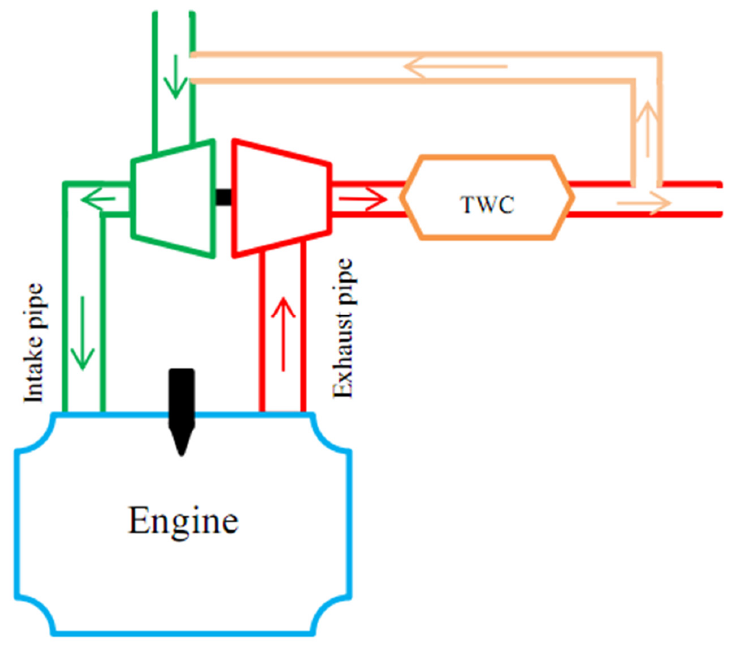
Figure 12. Clean eEGR circuits.